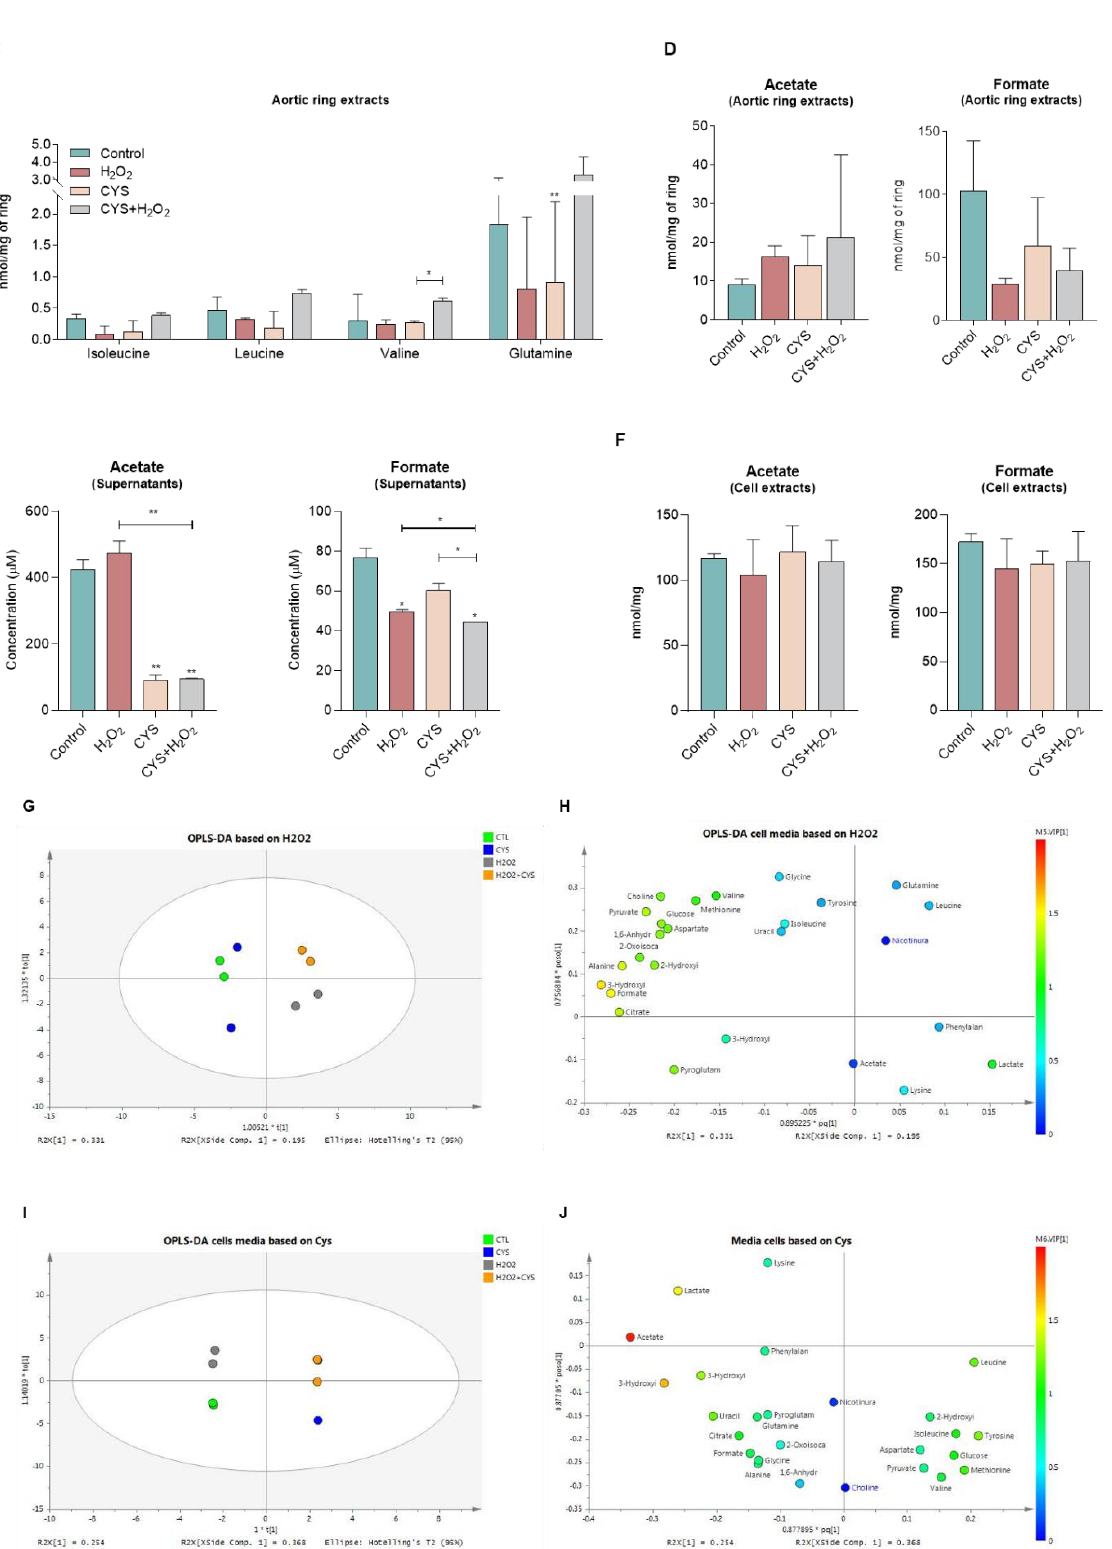
Figure 4. Oxidative stress mimicked by H 2 O 2 promotes aortic ring sprouting, while cysteine (CYS) reverses this effect. Sections of rat aortic rings were plated in Matrigel and cultured in basal culture condition (control) and with hydrogen peroxide (15 μM, H 2 O 2 ; ROS) in the presence or absence of cysteine (0.4 mM, CYS). Aortic rings’ endothelial cell sprouting was followed for 10 days. Cells iso- lated from aortic rings were cultured in the same conditions; then cell extracts were performed, and cell culture media (supernatants) were collected for nuclear magnetic resonance (NMR) spectros- copy analysis. ( A ) Representative images of rat aortic rings at day 10 (40×, scale: 200 μm). The rat aorta segments were exposed to H 2 O 2 and CYS, alone and in combination. ( B ) Sprouting quantifica- tion: number of branch points per sprout area (area around and inside the ring where sprouting was visible), normalized to the control. ( C ) Metabolite concentration of BCAAs (isoleucine and leucine), valine, and glutamine of extracts of aortic rings exposed to H 2 O 2 and/or CYS. ( D ) Acetate and for- mate levels in aortic ring extracts. ( E ) Acetate and formate levels in culture media of endothelial cells isolated from the sprouted aortic rings. ( F ) Acetate and formate levels of extracts from endo- thelial cells isolated from the sprouted aortic rings. Results are represented as mean ± SD. * p < 0.05, ** p < 0.01, *** p < 0.001; unpaired t- test (two-tailed) . Multivariate analysis of monocytes cultured under H 2 O 2 and/or cysteine — PLS-DA model from supernatants, using ( G ) H 2 O 2 and ( I ) cysteine as discriminant. Metabolites important for the separation of metabolic profiles upon ( H ) H 2 O 2 and ( J ) cysteine exposure. The score values determined the position of the different samples on the OPLS- DA score plot, and the loading vectors the importance of the metabolites for the construction of the OPLS-DA model. The t1-X-score vector value of the first predictive component, the to1-orthogonal X-score vector of the first component, the pq1-predictive loading vector of the first component, and the poso1-orthogonal X-loading vector of the first component. 3.4. CoCl 2 -Mimicked Hypoxia Inhibits the Sprouting of Aortic Rings The role of hypoxia was addressed by exposing aortic rings to CoCl 2 , and it was ver- ified that CoCl 2 inhibited the sprouting (Figure 5A). This inhibitory effect is clearly seen by the significant reduction of branch point density (Figure 5B). The exposure to CoCl 2 induced a metabolic profile adjustment with an increase in glutathione, amino acids, glycids, purine, and pyrimidine metabolism (Figure 5C), together with a decrease in the levels of BCAAs, valine, and glutamine (Figure 5D). A trend for an increase in acetate and a decrease in formate levels was observed (Figure 5E,F).